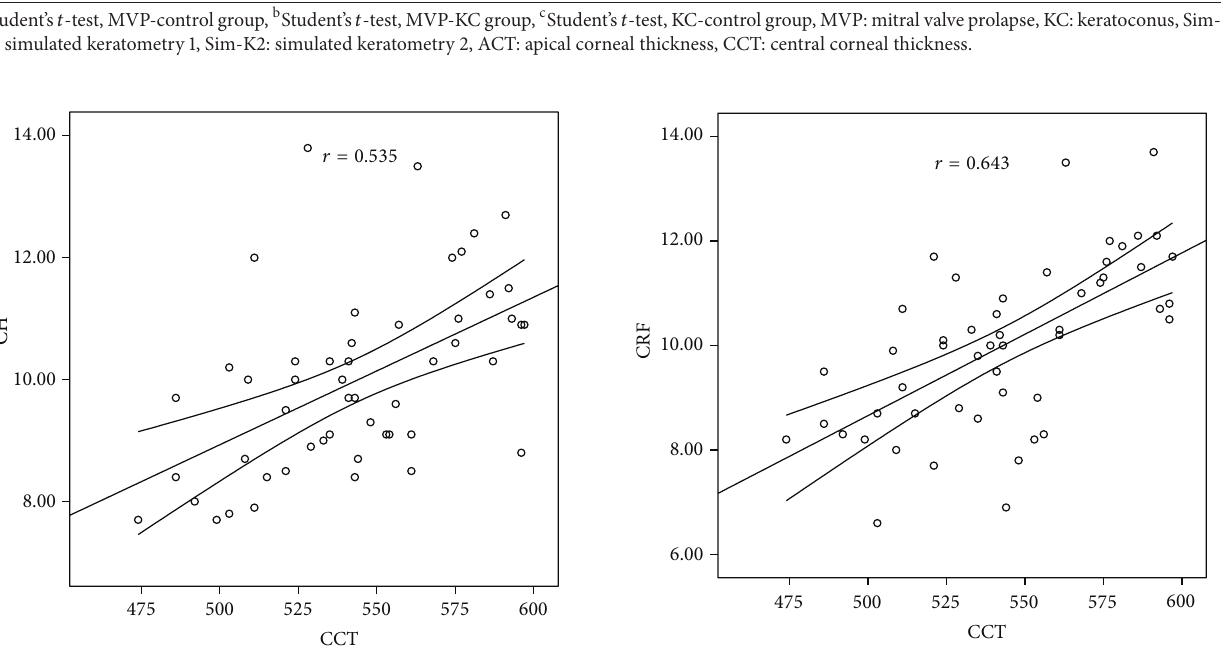
Figure 1: Correlation graphic between CH and CCT. CH: corneal hysteresis, CCT: central corneal thickness.